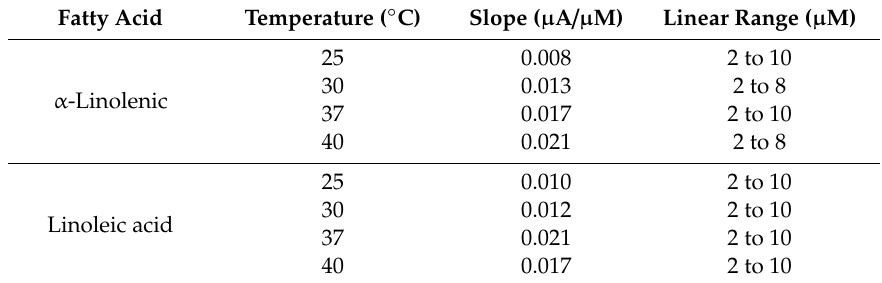
Table 2. Slopes and linear ranges of α -linolenic and linoleic acid at pH 8.0 and 25, 30, 37 and 40 ◦ C. Fatty Acid Temperature ( ◦ C) Slope ( µ A / µ M) Linear Range ( µ M)